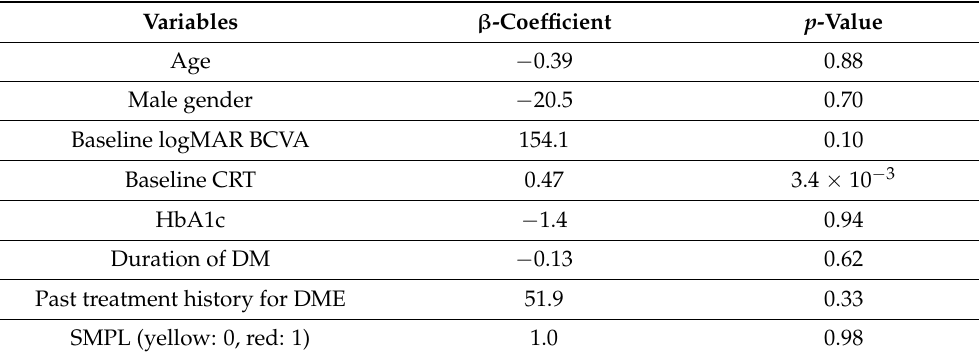
Table 3. Multivariate linear regression analysis of factors associated with mean CRT at 12